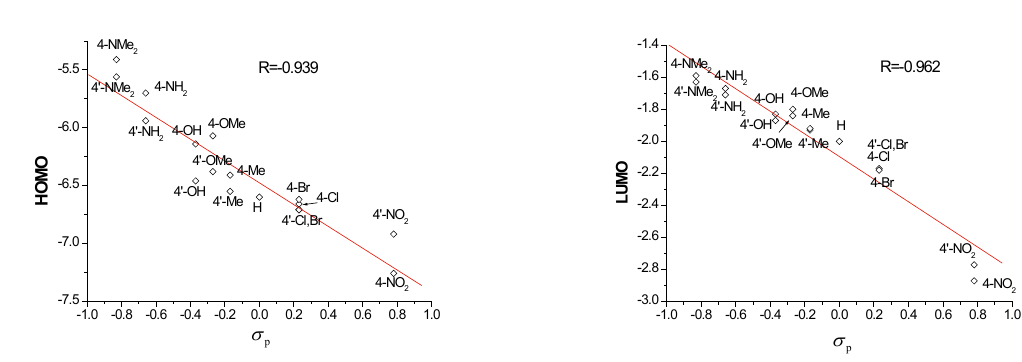
Figure 3. The relationship between the energies of HOMO (left) and LUMO (right) and Hammett constants σ